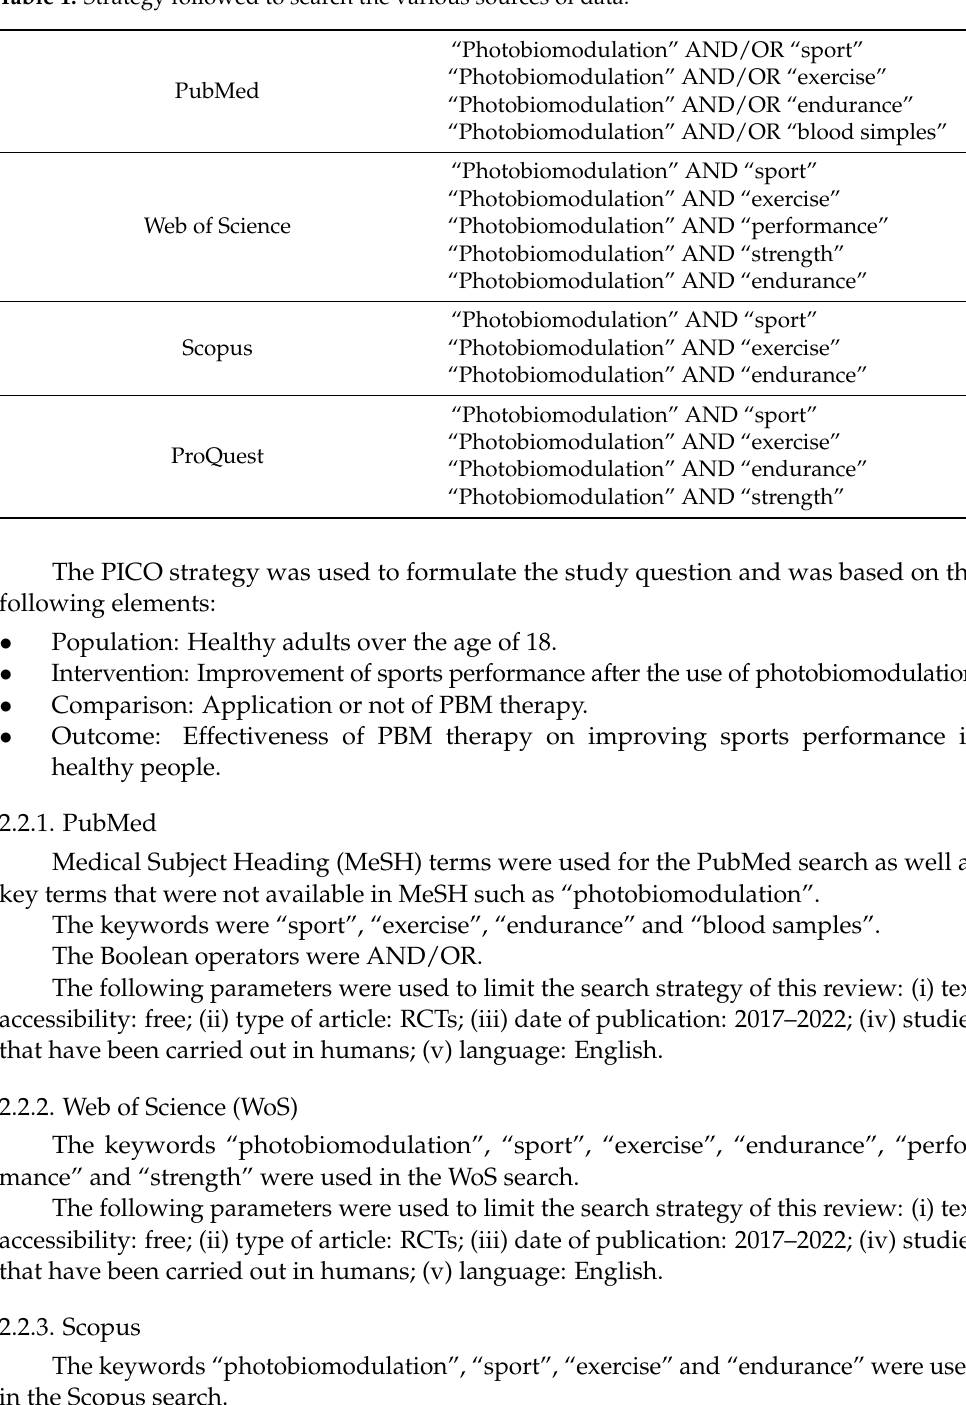
Table 1. Strategy followed to search the various sources of